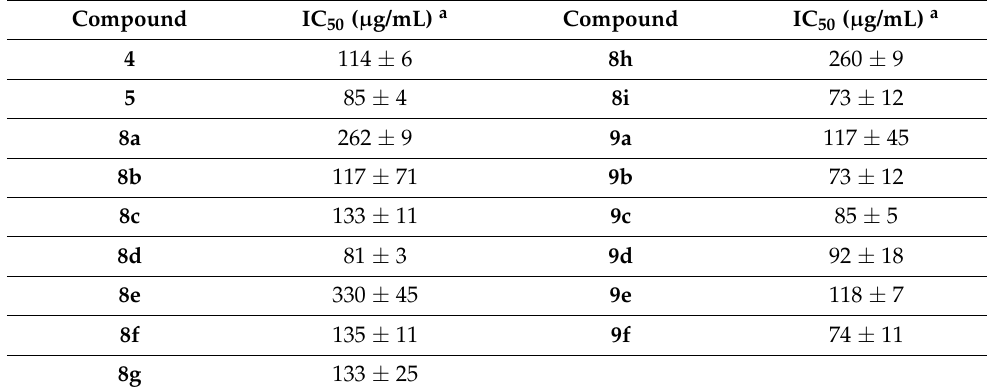
Table 2. In vitro cytotoxicity of compounds 4 , 5 , 8 , and 9